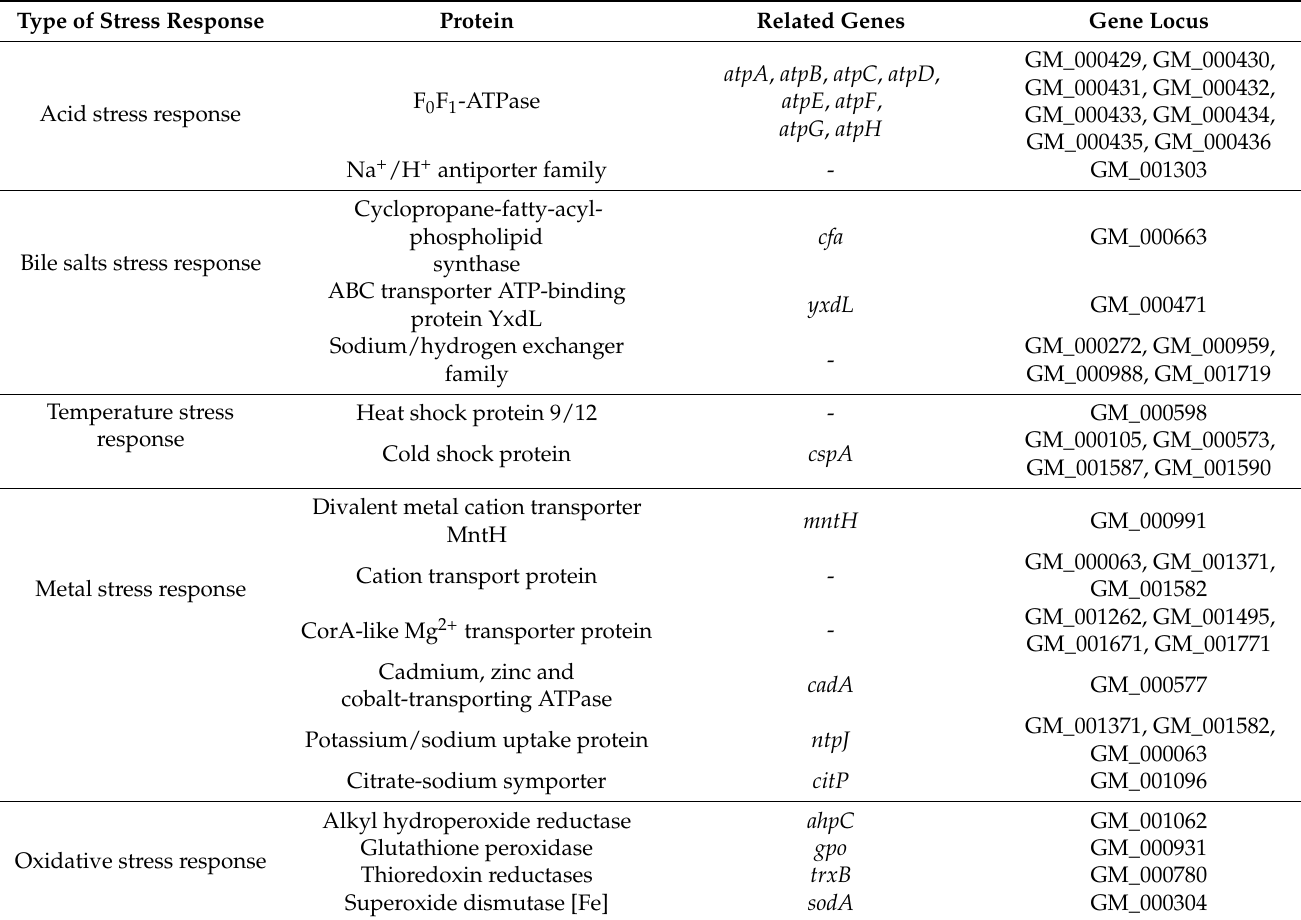
Table 4. Stress-responsive proteins of Lactococcus garvieae FUA009 in the whole genome.